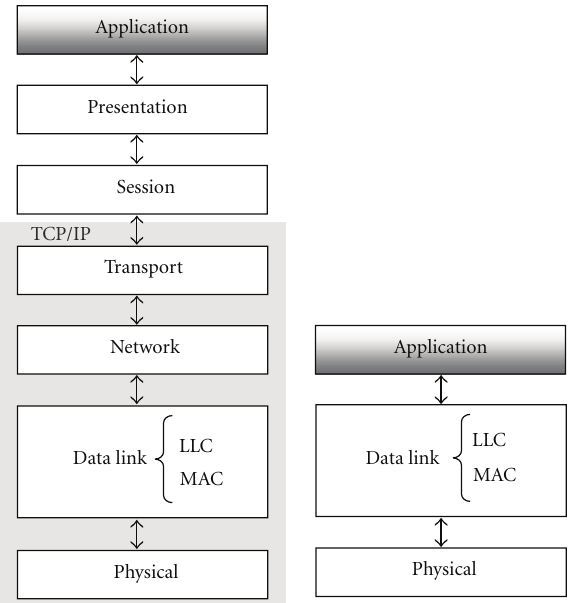
Figure 1: Comparison of a common OSI model and a reduced one for WSN